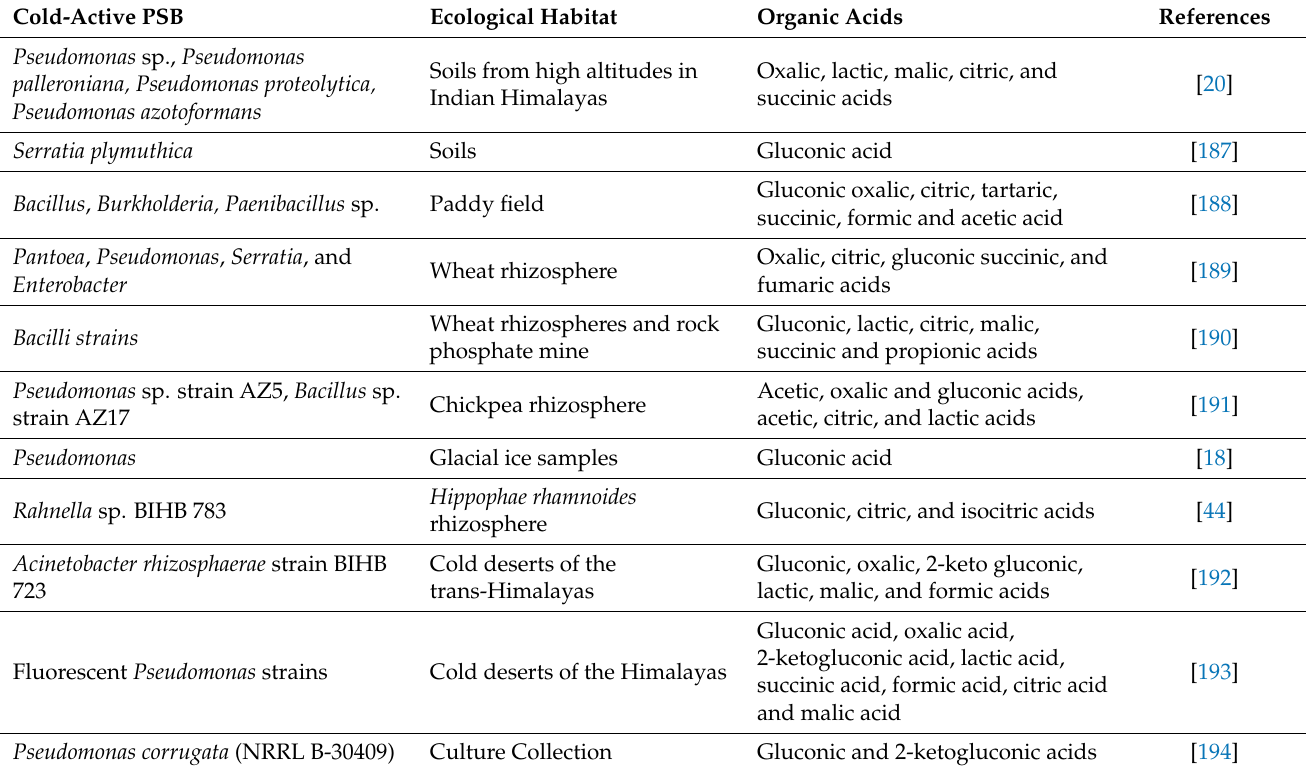
Table 2. Organic acids secreted by cold-active phosphate solubilizing